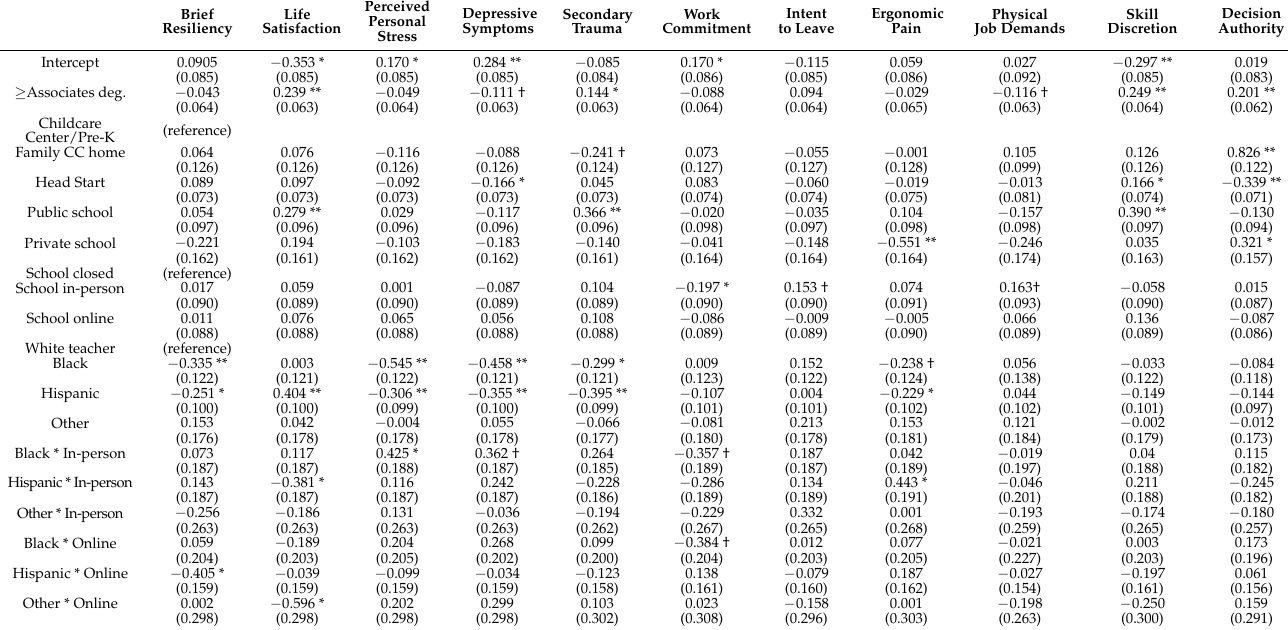
Table 5. Moderation of teacher race and psychological, physical, and professional well-being out- comes by